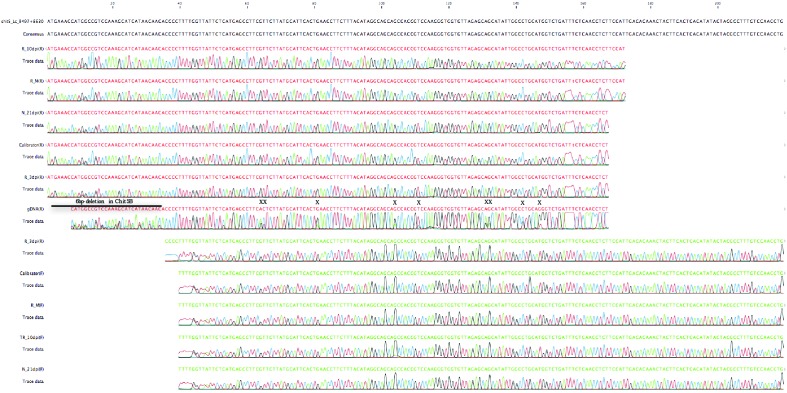
Sequencing traces from PCR products using genomic DNA (gDNA), cDNA from water treated roots (R_M), M.loti inoculated roots-3dpi (R_3dpi),−10dpi (R_10dpi) and nodules-21 dpi (N_21dpi) as template.Calibrator template contains a mixture of L. japonicus cDNAs from various organs and M.loti infected roots and nodules. The PCR products were sequenced with forward (F) or reverse primer (R). Note that sequences from gDNA have double peaks in the regions with nucleotide polymorphisms between chitinase paralogs (X and line), while the cDNA sequences have only one variant corresponding to Chit5.